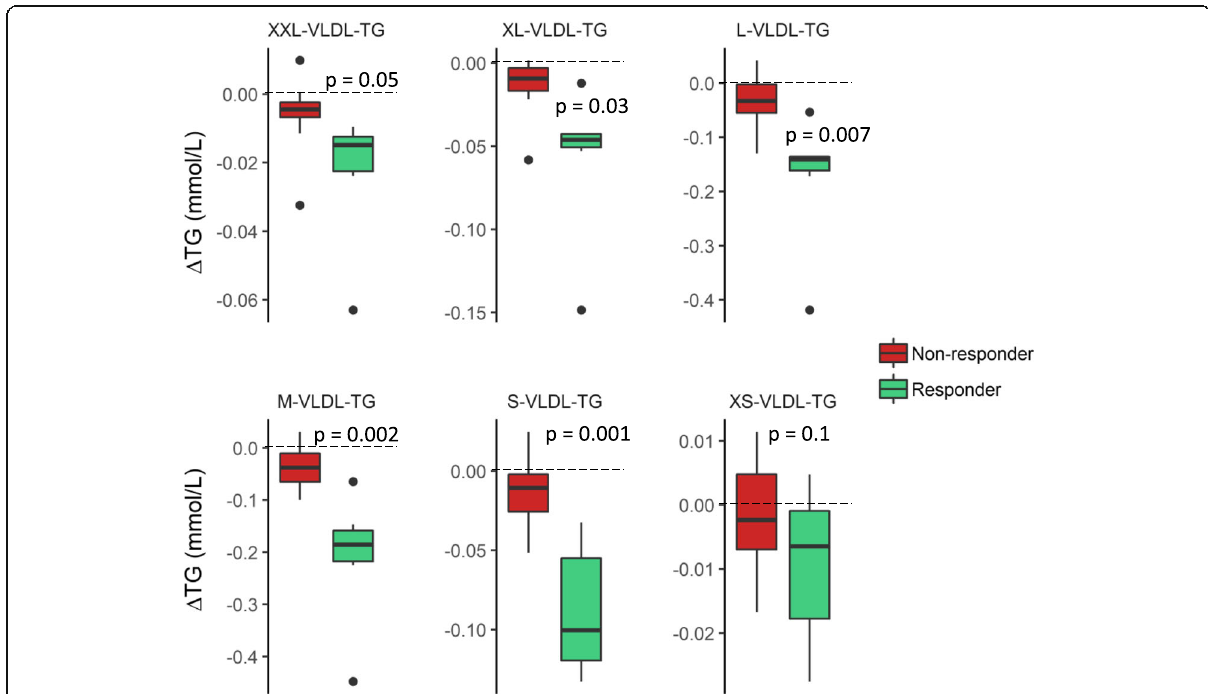
Fig. 3 Change in triglyceride levels in VLDL subclasses. The change in TG levels in XXL-, XL-, L-, M-, S-, and XS-VLDL subclasses from baseline to end of study ( Δ mmol/L) in responders (green) and non-responders (red). Differences are tested on the log 2 ratio with an independent t test